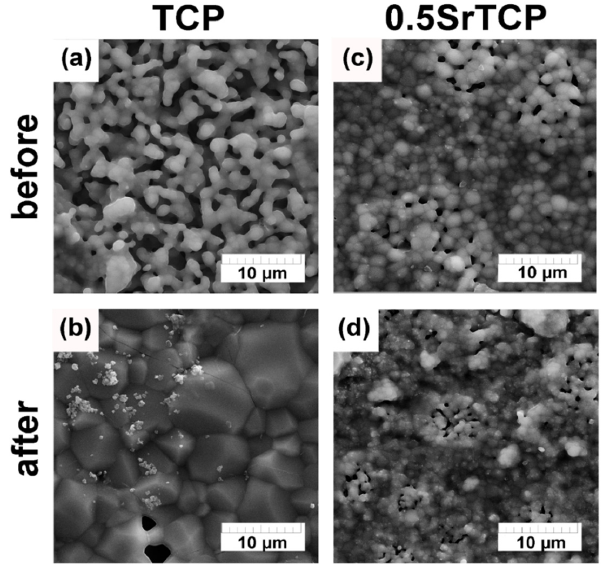
Figure 8. SEM images of TCP and 0.5SrTCP ceramic microstructure before ( a , b ) and after soaking in saline solution for 21 days ( c , d ).